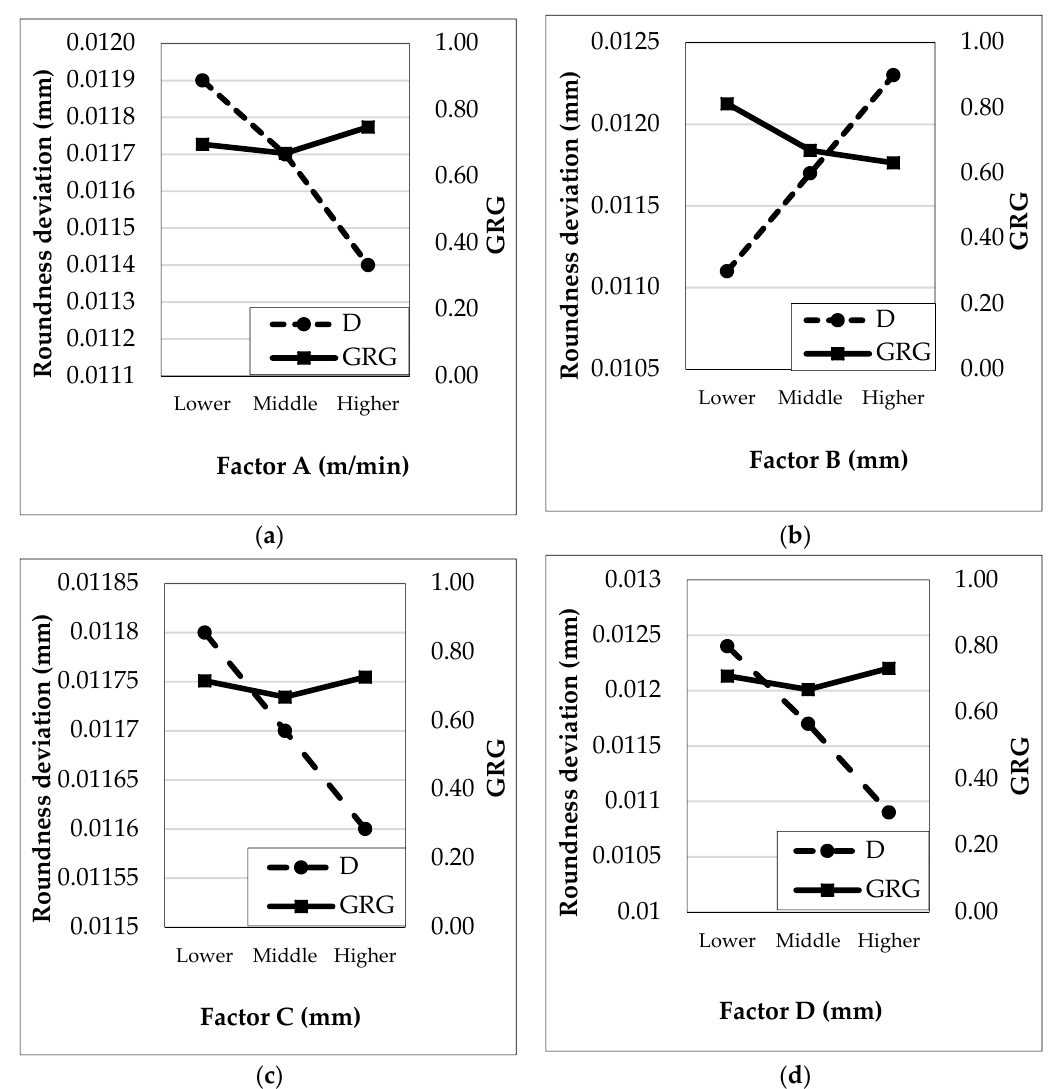
Figure 18. ( a ) Effect of cutting speed factor on the roundness deviation qualitative parameters; ( b ) Effect of feed rate factor on the roundness deviation qualitative parameters; ( c ) Effect of depth of cut factor on the roundness deviation qualitative parameters; ( d ) Effect of corner radius factor on the roundness deviation qualitative parameters.